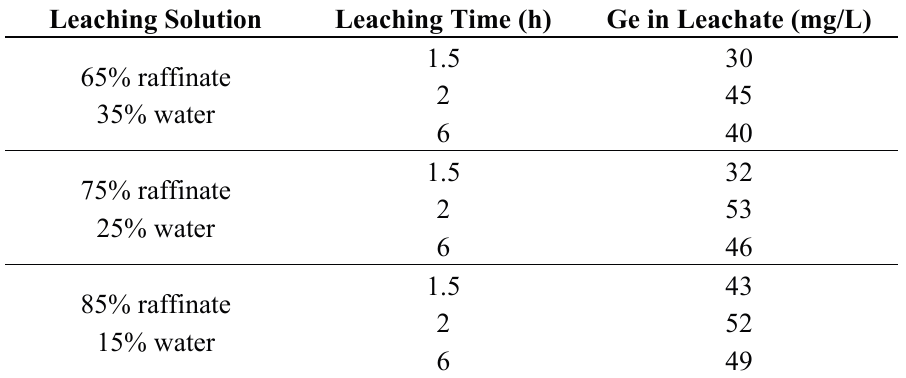
Table 2. Leaching tests with different raffinate/water ratios and residence